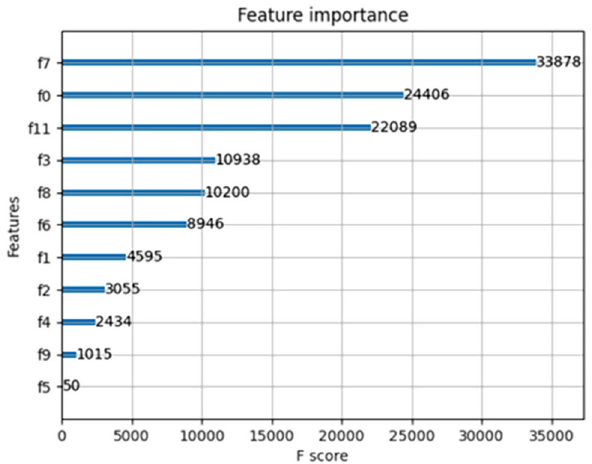
Figure 4. Feature importance of donors for recruitment models. The trained XGBoost model automatically calculated feature importance with a f(eature) score on 13 features associated with willingness to donate blood, we could see that the plot shown F7 (donation interval) had the highest importance and F5 (blood test) had the lowest importance. The features such as donation interval, age, and donation frequency having a strong correlation with blood donors’ intention to donate blood, were considered more important than other features. Besides, total donation volume, education level and professional occupation also played important roles